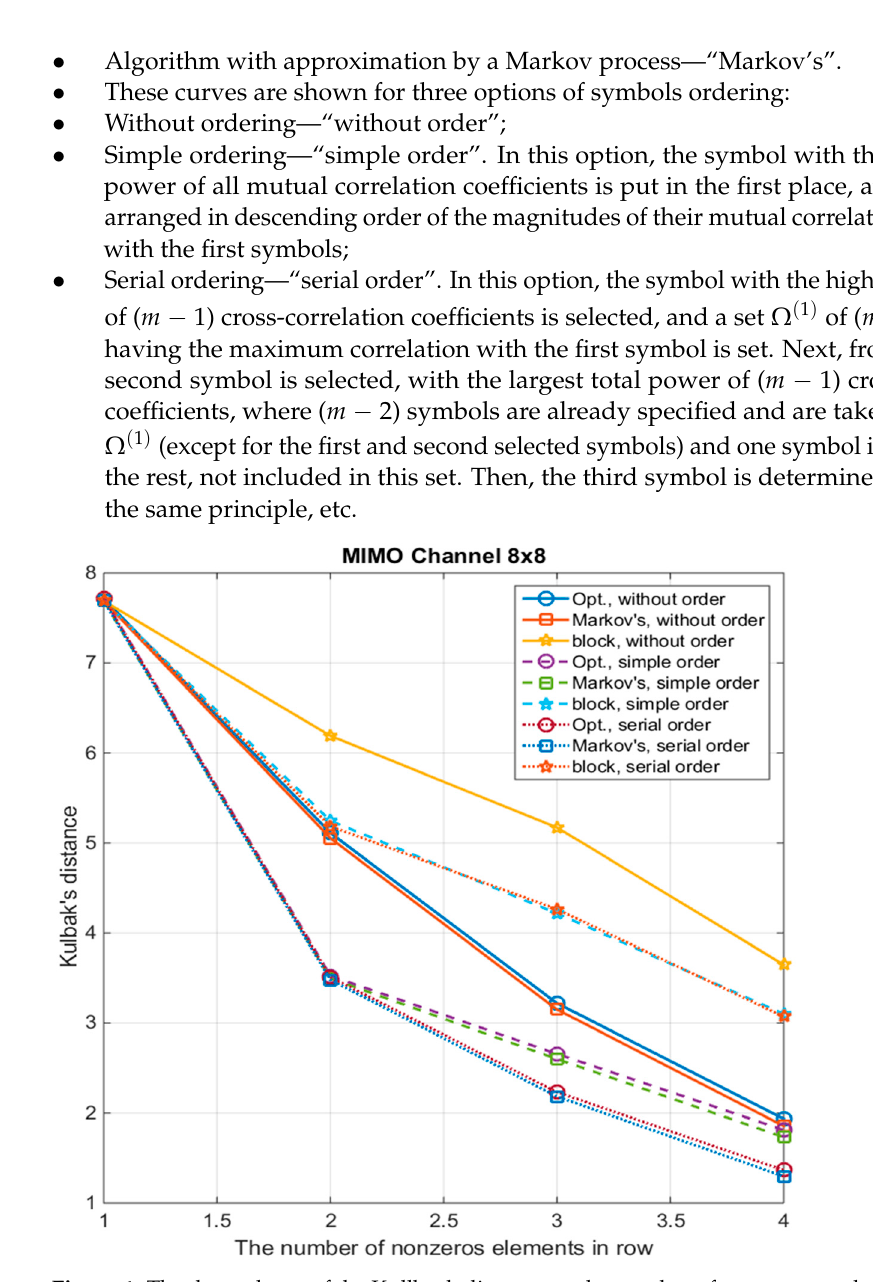
Figure 1. The dependence of the Kullback distance on the number of non-zero symbols in the sparsed channel matrix for different methods of multiple-input multiple-output (MIMO) channel matrix sparsification and for different types of symbol ordering.